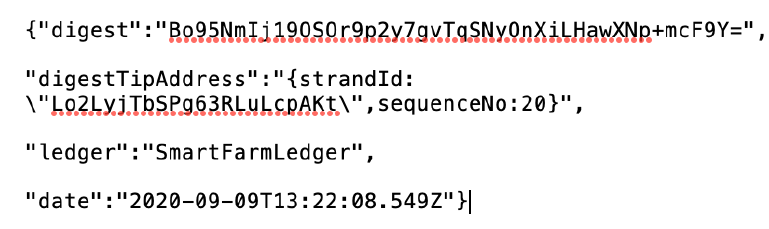
Figure 9. The SHA-256 hash value, which is used to verifying the latest committed block and validity of the journal.